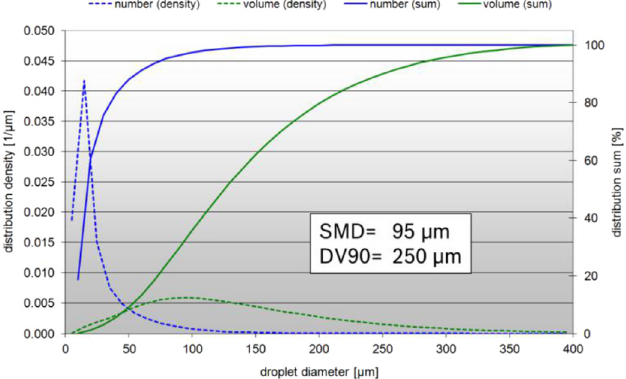
Fig. 6. Droplet size distribution.